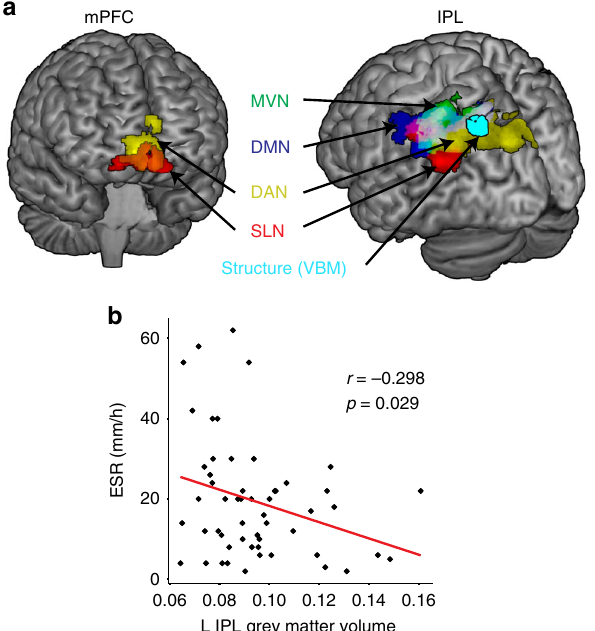
Fig. 3 Overlap of in fl ammation-associated functional connectivity changes. a Brain regions (medial prefrontal cortex [mPFC], inferior parietal lobule [IPL]) showing positive connectivity to the different networks (medial visual network [MVN], default mode network [DMN], dorsal attention network [DAN], salience network [SLN]) at higher levels of peripheral in fl ammation measured by erythrocyte sedimentation rate (ESR). Area of reduced grey matter volume is shown in light blue. This was identi fi ed by testing the association of ESR with grey matter volume derived through voxel-based morphometry (VBM) in 8 mm spheres extracted around the signi fi cant peak cluster coordinates from the session 1 network to whole- brain connectivity analyses, in multiple linear regression analyses controlling for age and sex at p < 0.05 uncorrected. b Scatterplot showing the association between ESR and grey matter volume. Displayed at p = 0.005 voxel threshold corrected for age and sex